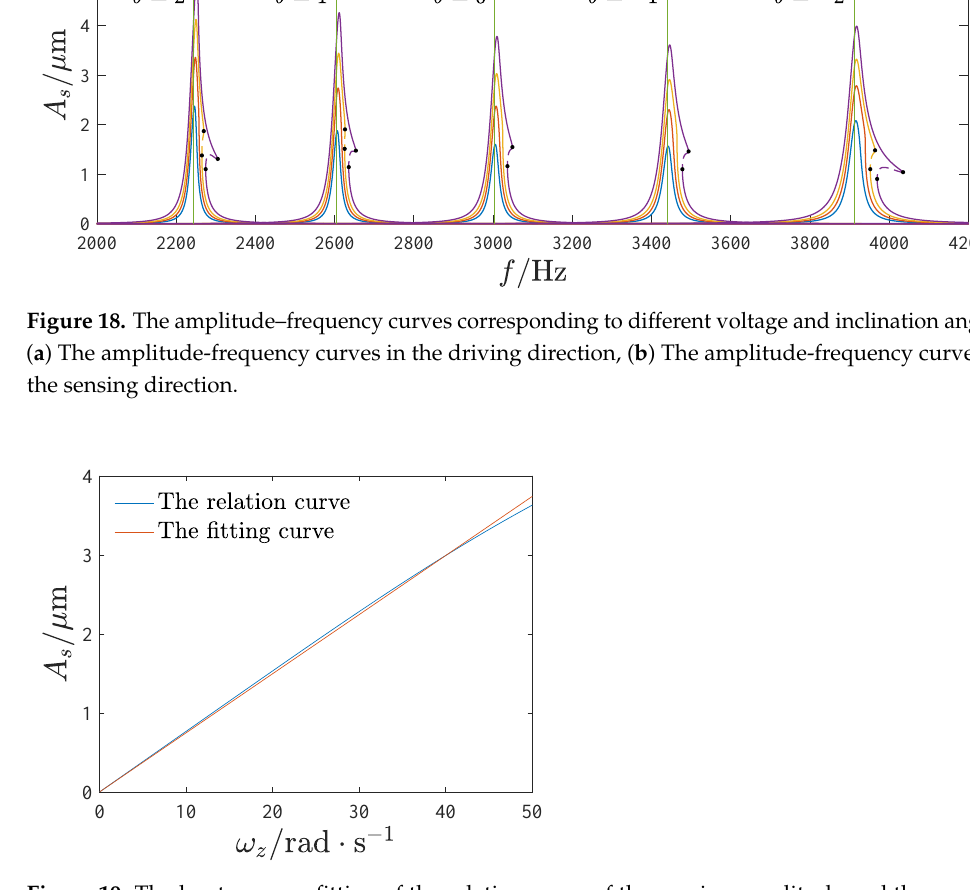
Figure 19. The least-squares fitting of the relation curve of the sensing amplitude and the angular velocity, V E = 15 V, θ = 1 ◦